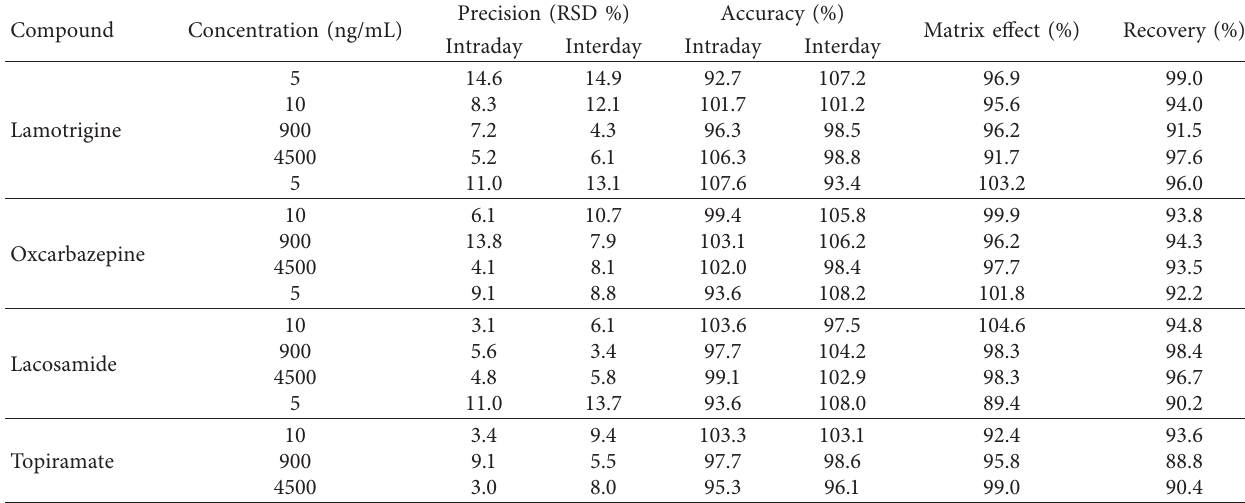
Table 2: Accuracy, precision, matrix effect, and recovery of lamotrigine, oxcarbazepine, lacosamide, and topiramate in rat plasma.